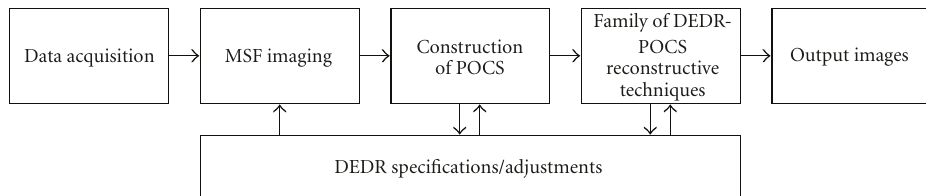
Figure 2: General framework of the DEDR